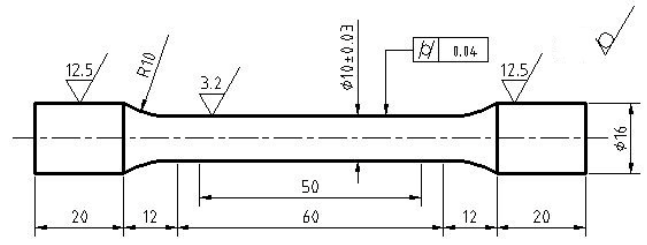
Figure 1. Diagram of tensile samples.